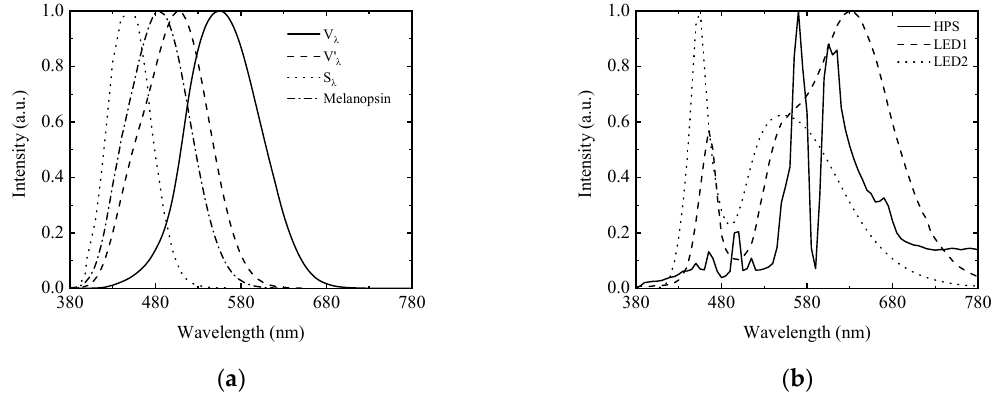
Figure 2. ( a ) The relative spectral sensitivity curve of the photopic vision V λ , scotopic vision V’ λ , S-cone fundamental S λ, and melanopsin sensitivity curve Mc λ (corrected for crystalline lens transmittance). ( b ) Spectral power distributions of high-pressure sodium (HPS), phosphor-converted (PC) light-emitting diode (LED) 1, and PC LED 2 with CCT 2238 K, 2497 K, and 6060 K, respectively.